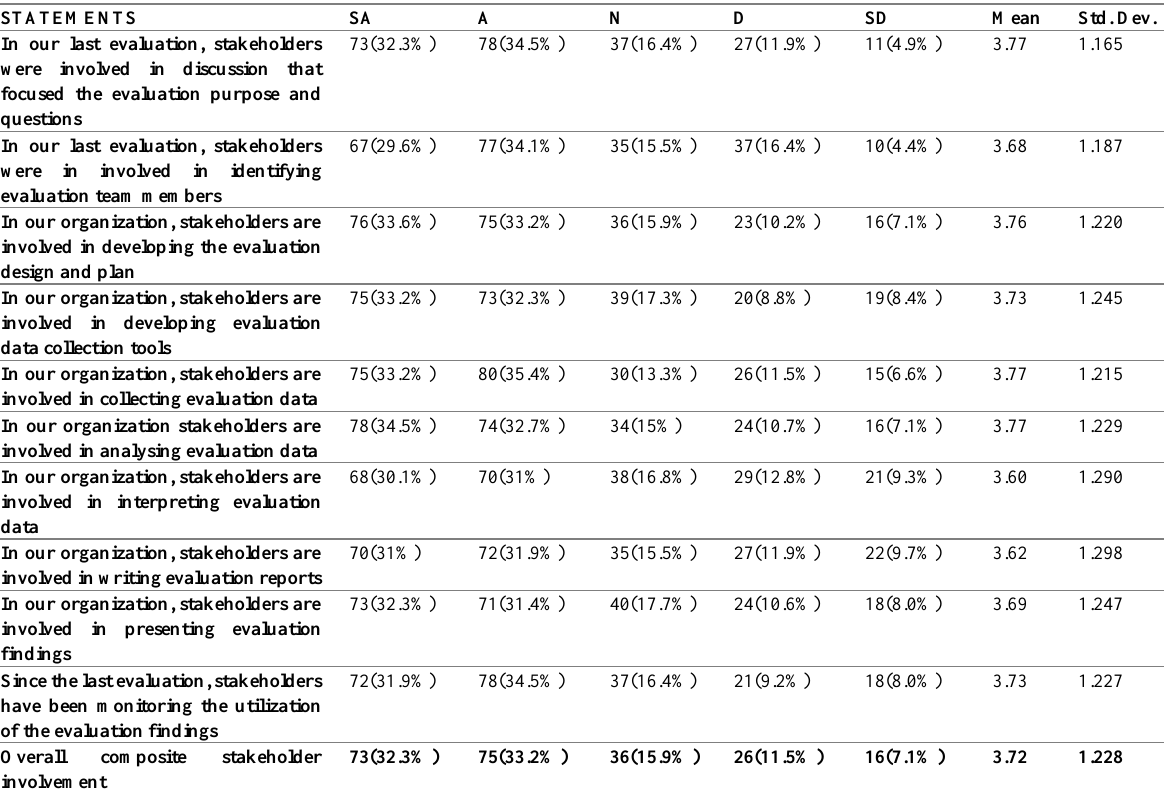
Table 3: Stakeholder involvement in evaluations and Utilization of Evaluation